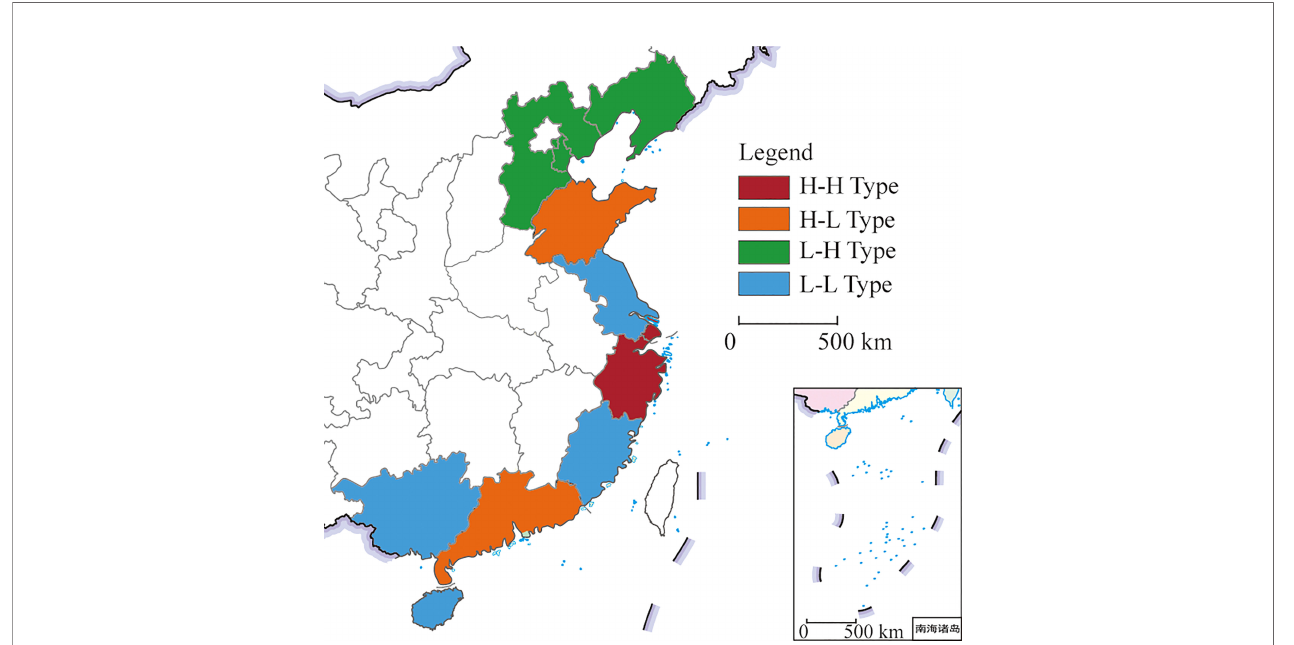
FIGURE 5 | Space partition of the high-quality development level of the marine economy in 11 coastal provinces (cities and